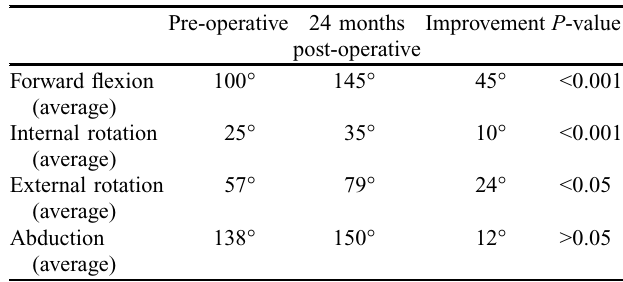
Table 2. Primary outcome measures (ranges of motion) 24 months post-operative.